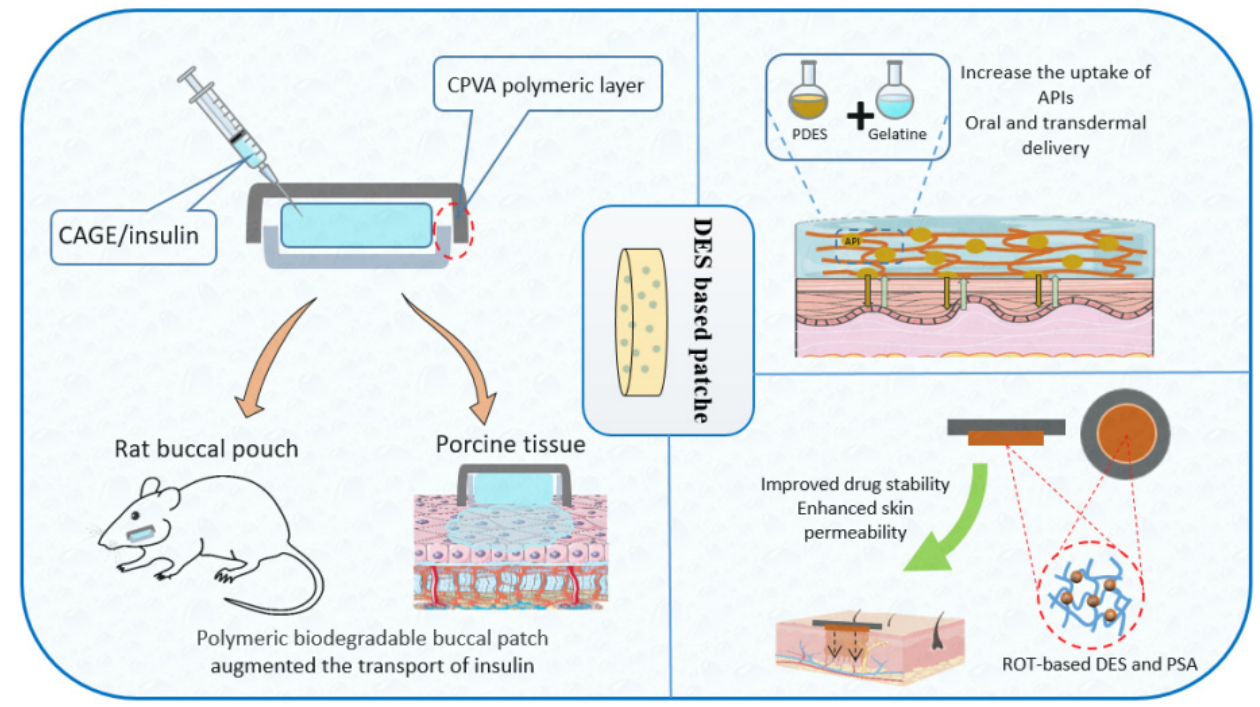
Figure 6. Applications of DES-patches.